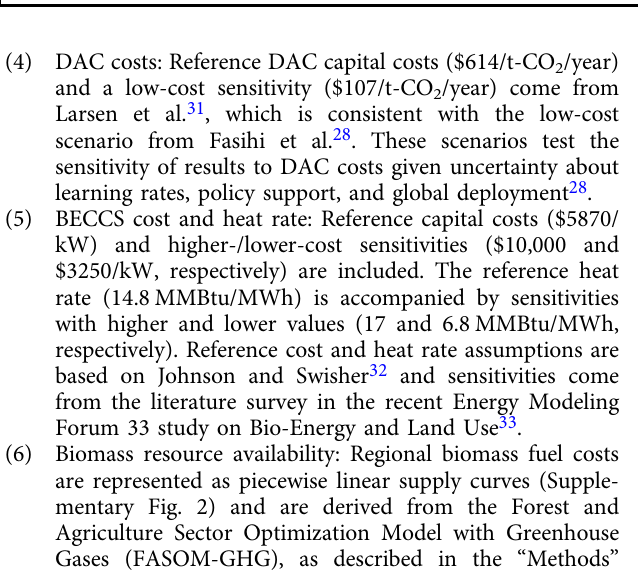
CO 2 transport/storage cost Endogenous; varies by location Reference BECCS assumptions are based on Johnson and Swisher 32 , and DAC assumptions are based on Larsen et al. 31 . All values are expressed in 2018 US dollars. DAC parameters are normalized to net removal at the plant per metric ton of CO 2